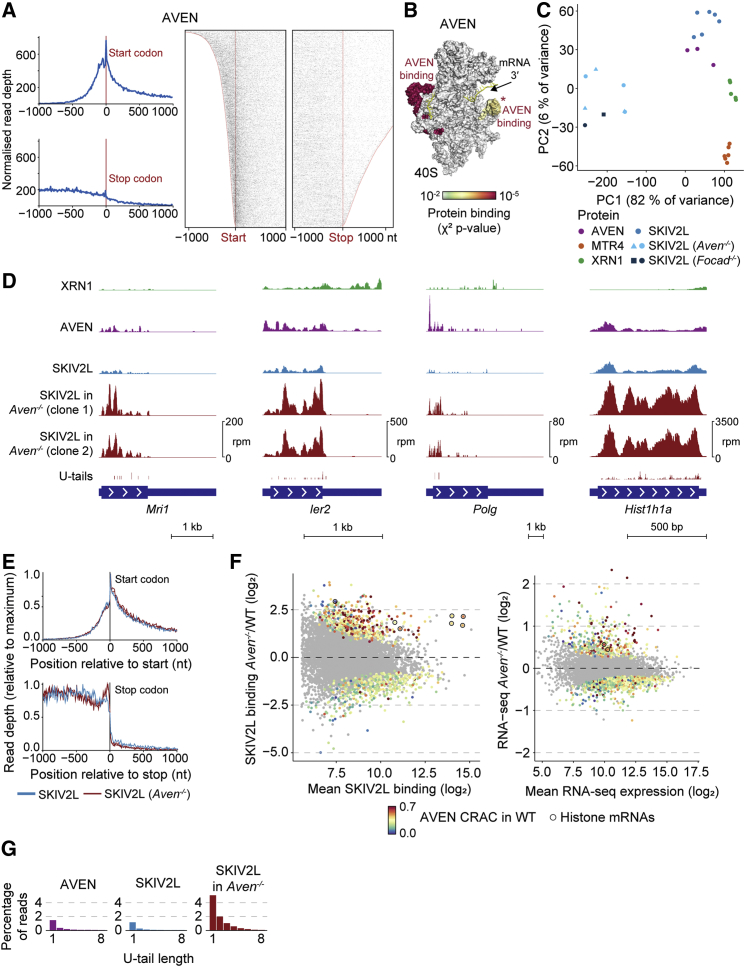
SKIV2L Binding and 3′–5′ Decay Increase upon Aven Knockout(A and B) CRAC signal for AVEN around start and stop codons (A) and on the ribosomal 40S subunit (B).(C) PCA based on mRNA counts. Shapes indicate different clones.(D) CRAC coverage for individual mRNAs.(E) SKIV2L CRAC around start and stop codons in WT and Aven−/− cells.(F) Changes in SKIV2L CRAC binding (left) and RNA-seq counts (right) for Aven−/− versus WT cells. Significantly up/downregulated transcripts (padj < 0.05) are colored by AVEN CRAC counts in WT cells, relative to SKIV2L+XRN1+MTR4 counts, and replication-dependent histone mRNAs are circled.(G) Proportion of AVEN or SKIV2L CRAC reads in mRNAs with 3′ U-tails.See also Figure S3 and Table S3.